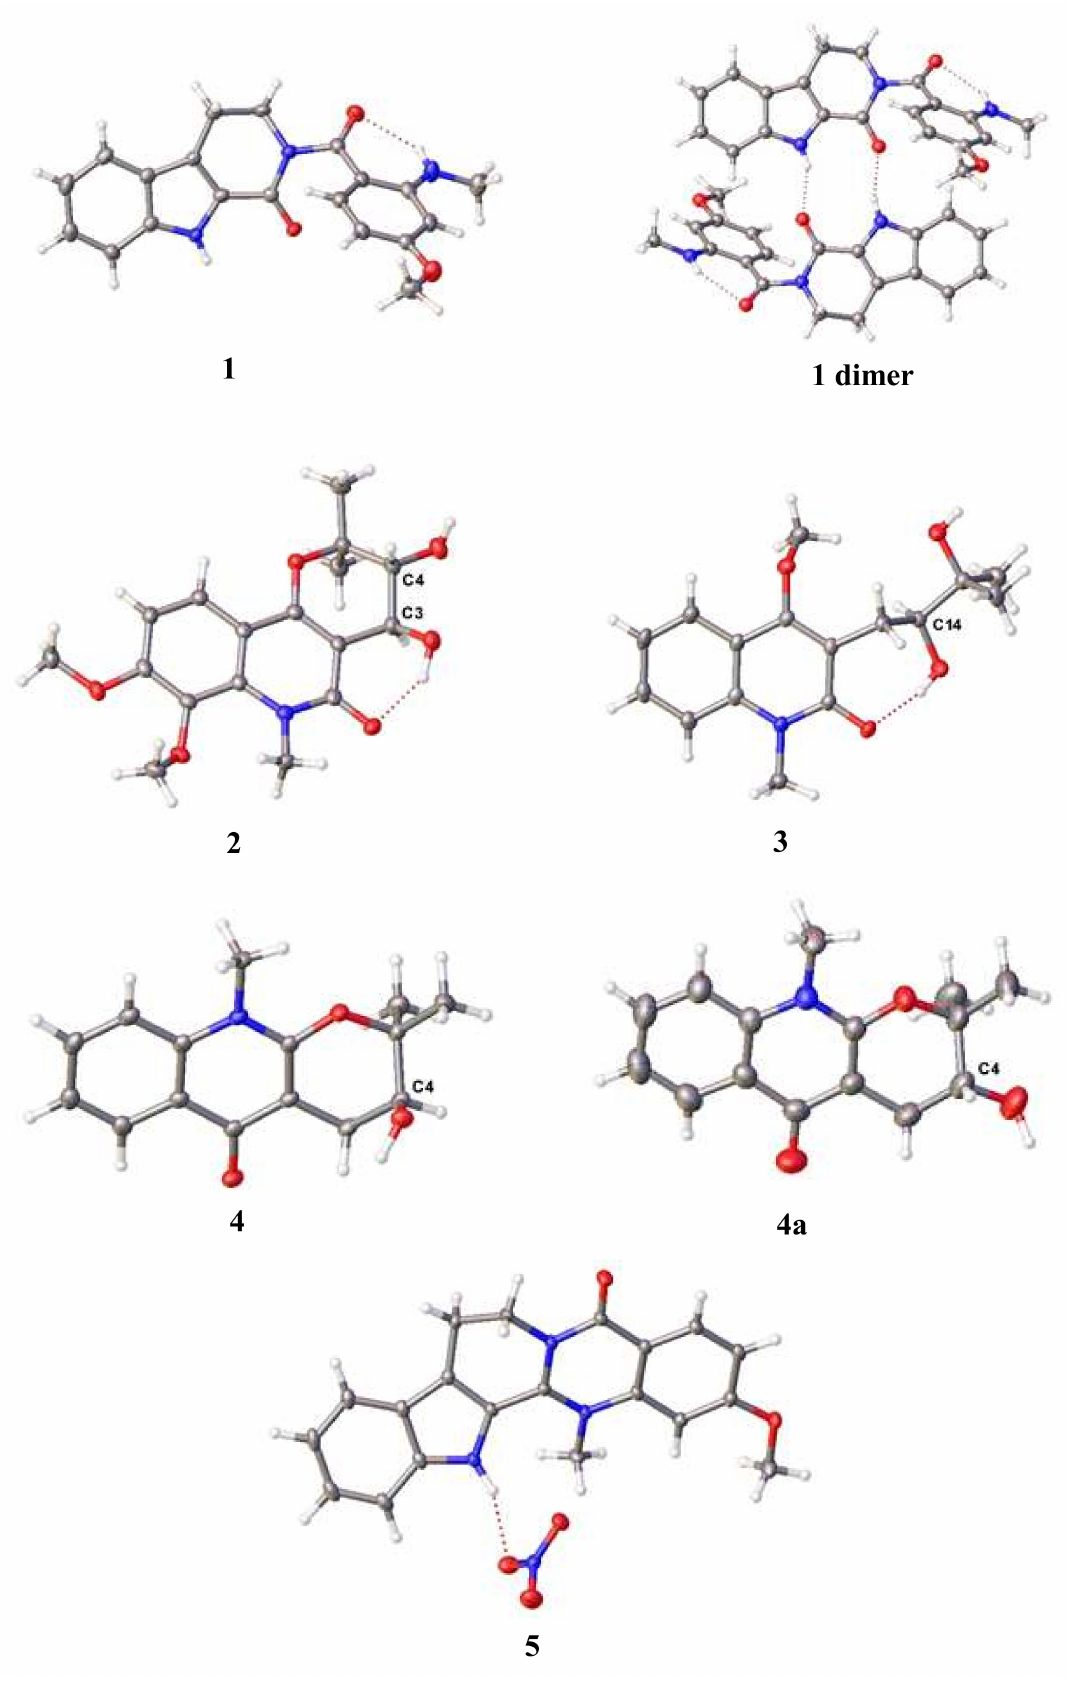
Figure 3. Molecular structures of the crystals of 1 – 4 , 4a and 5 in ORTEP style at 50% probability